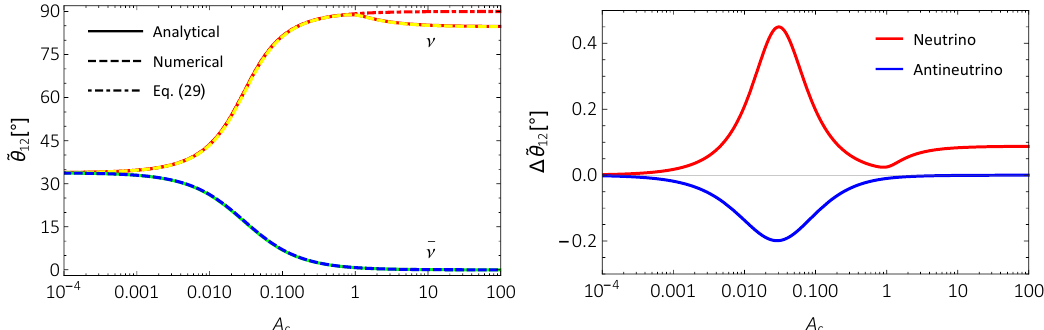
in the case of normal neutrino 12 between the full result 12